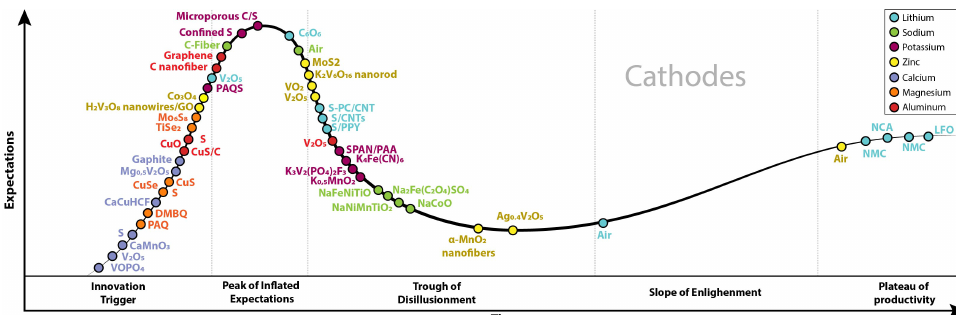
Figure 15. Graph constructed by the authors from Gartner hype cycle for promising cathode materials for batteries. Materials are grouped according to the seven battery types: Li, Na, K, Zn, Ca, Mg, and Al. Each material is organized into a stage according to the estimation of development among innovation and productivity